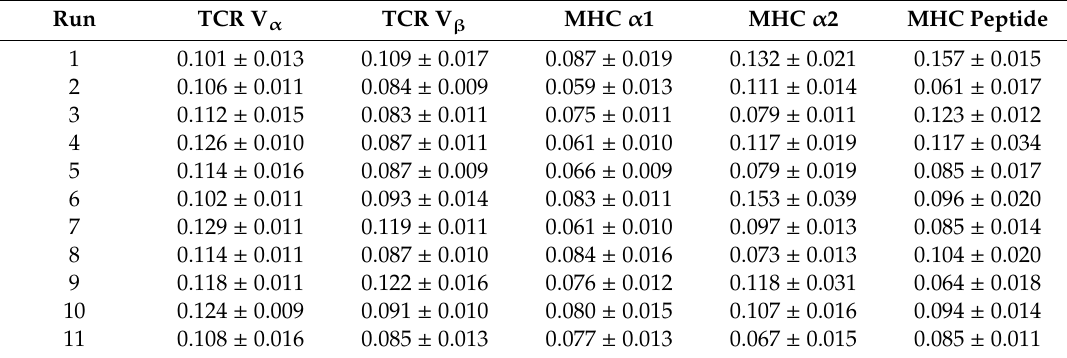
Table 1. RMSD (mean ± SD) in nm for various domains of the unbound molecules TCR and pMHC as calculated from 20 (10 for free TCR and 10 for free MHC) 40 ns MD runs (1–10) and from two (free TCR and free MHC) 400 ns MD runs (11).